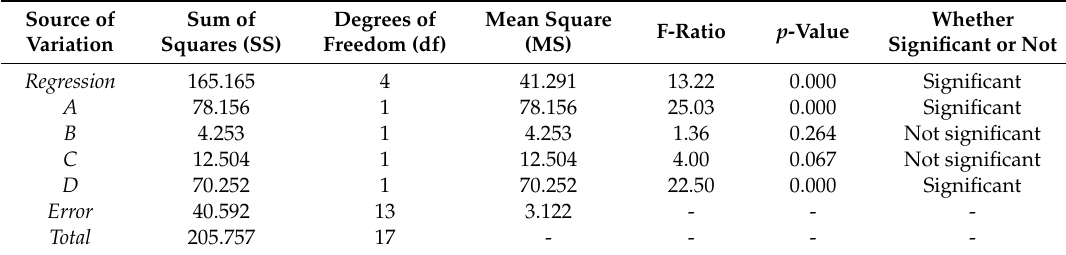
Table 13. ANOVA results for regression.